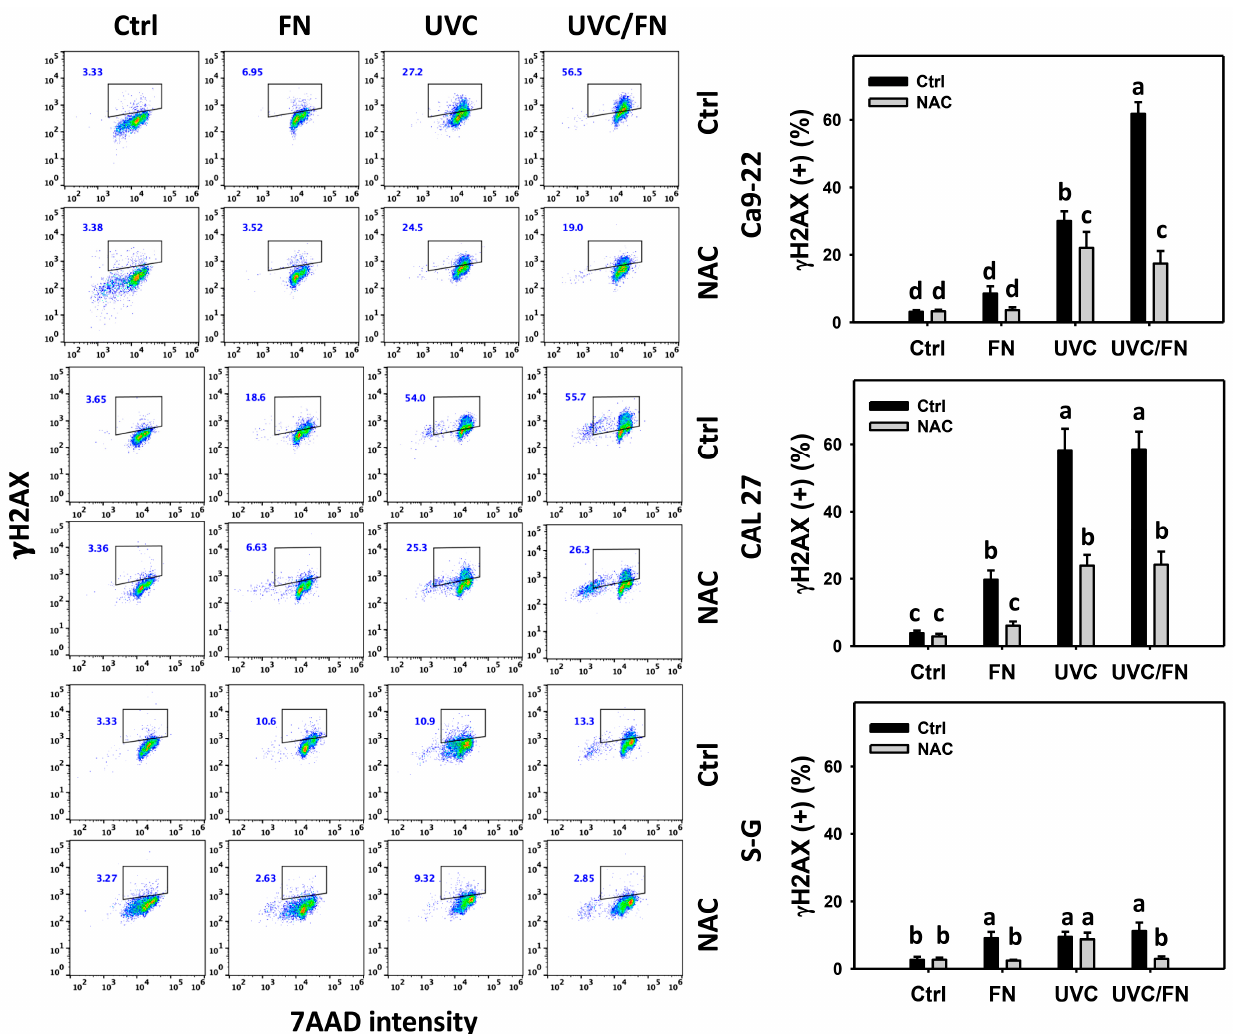
Figure 9. γ H2AX determination. There are four kinds of treatments for oral cancer and non-malignant oral (S–G) cells: control, FN (300 µ g/mL), UVC (10 J/m 2 for Ca9-22; 15 J/m 2 for CAL 27 and S–G), and UVC/FN (10 J/m 2 /300 µ g/mL for Ca9-22; 15 J/m 2 /300 µ g/mL for CAL 27 and S–G). NAC indicates that cells were pretreated with 10 mM NAC. Their intensity changes were evaluated by flow cytometry after a 24 h treatment. γ H2AX (+) populations are indicated with (+). Data are provided as means ± SD ( n = 3). The lower-case letters indicate significant differences when not overlapping ( p < 0.05).